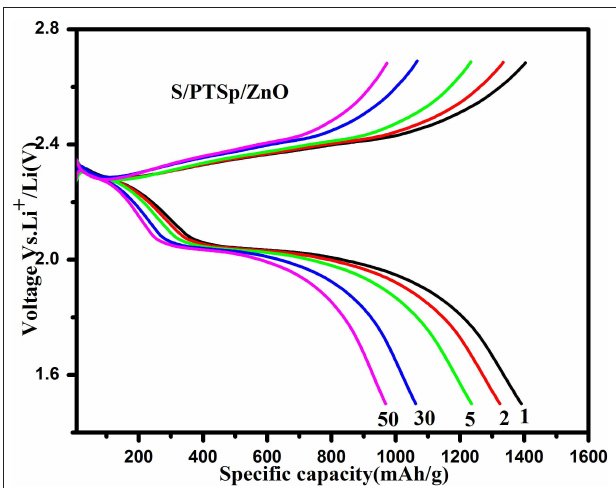
FIGURE 9 | Cyclic voltammetry curves of the S/PTSp/ZnO composite potential range from 1.5 to 3V (verses Li + /Li).